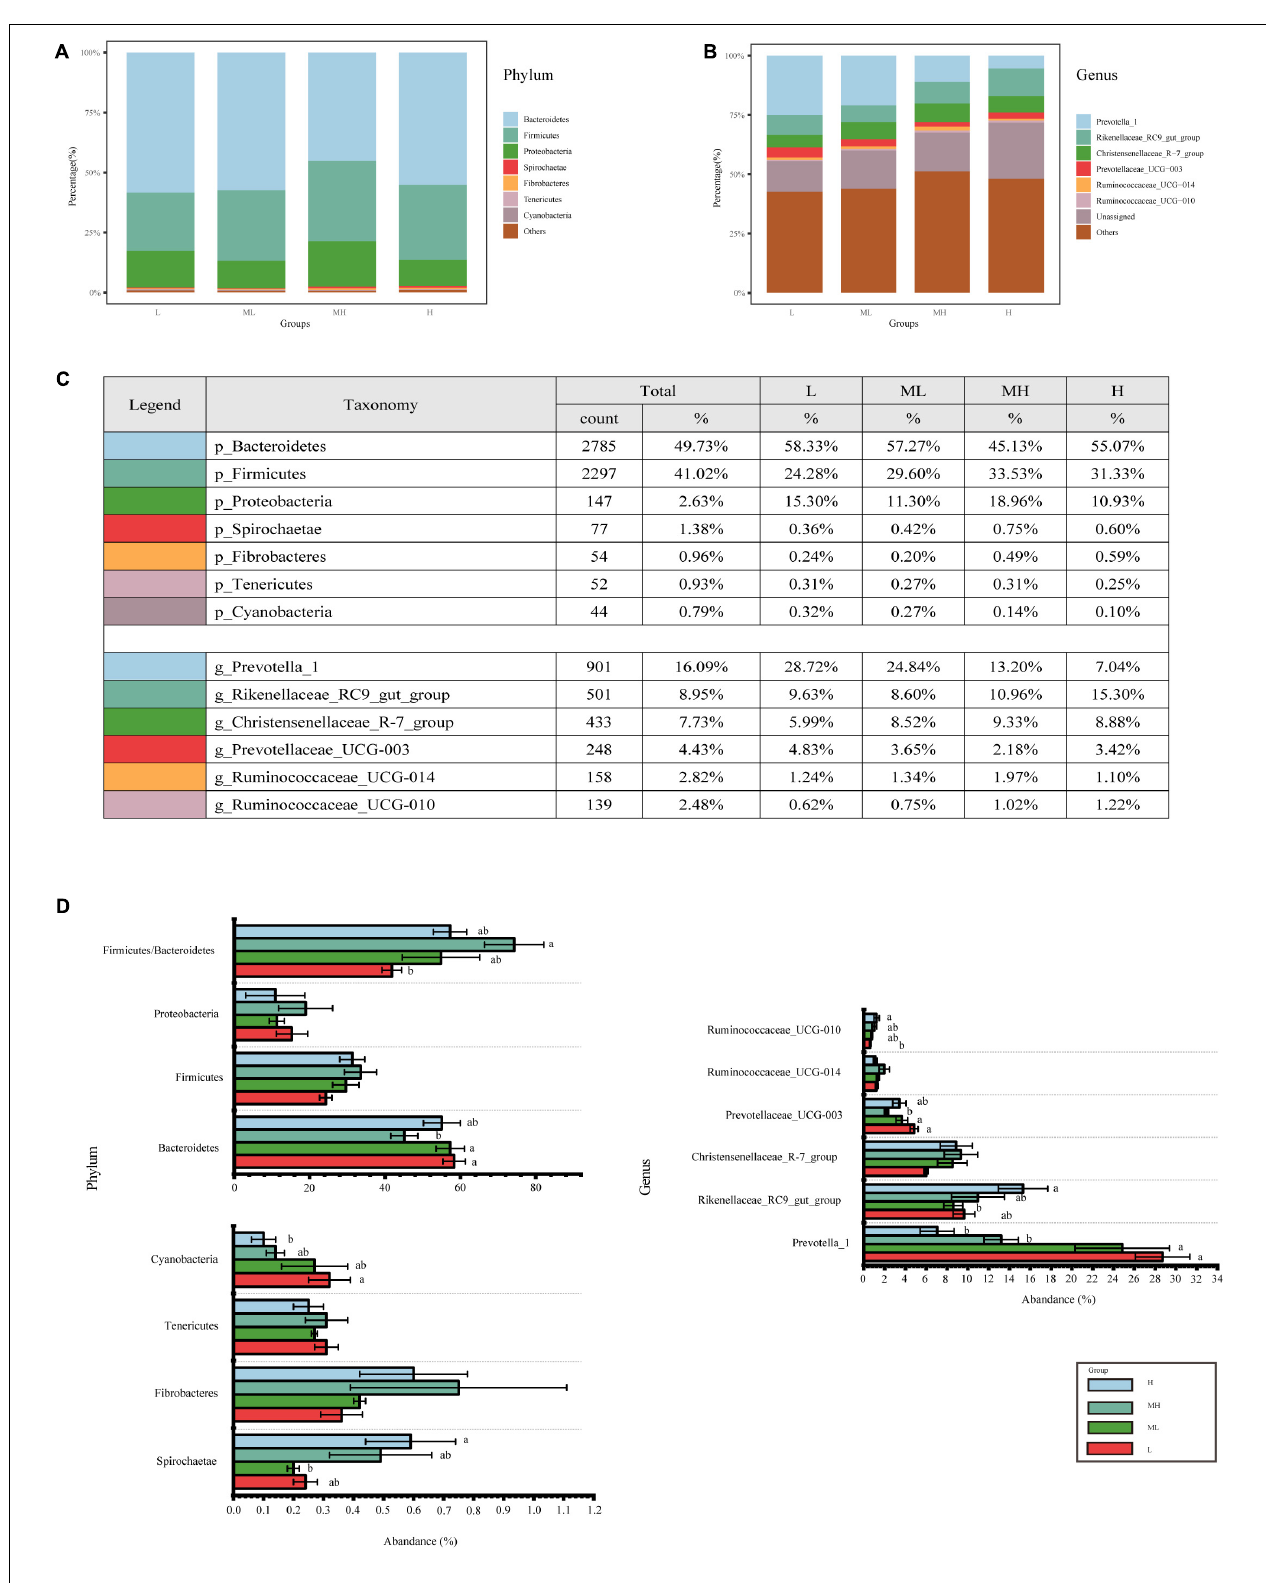
FIGURE 2 | Bacterial composition of rumen samples collected from yaks fed diets with different protein levels. Bacterial composition at the (A) phylum and (B) genus level, (C) further details for the top phylum and genus; (D) bacterial genera with significant differences among groups, different letters indicate a significant difference between the